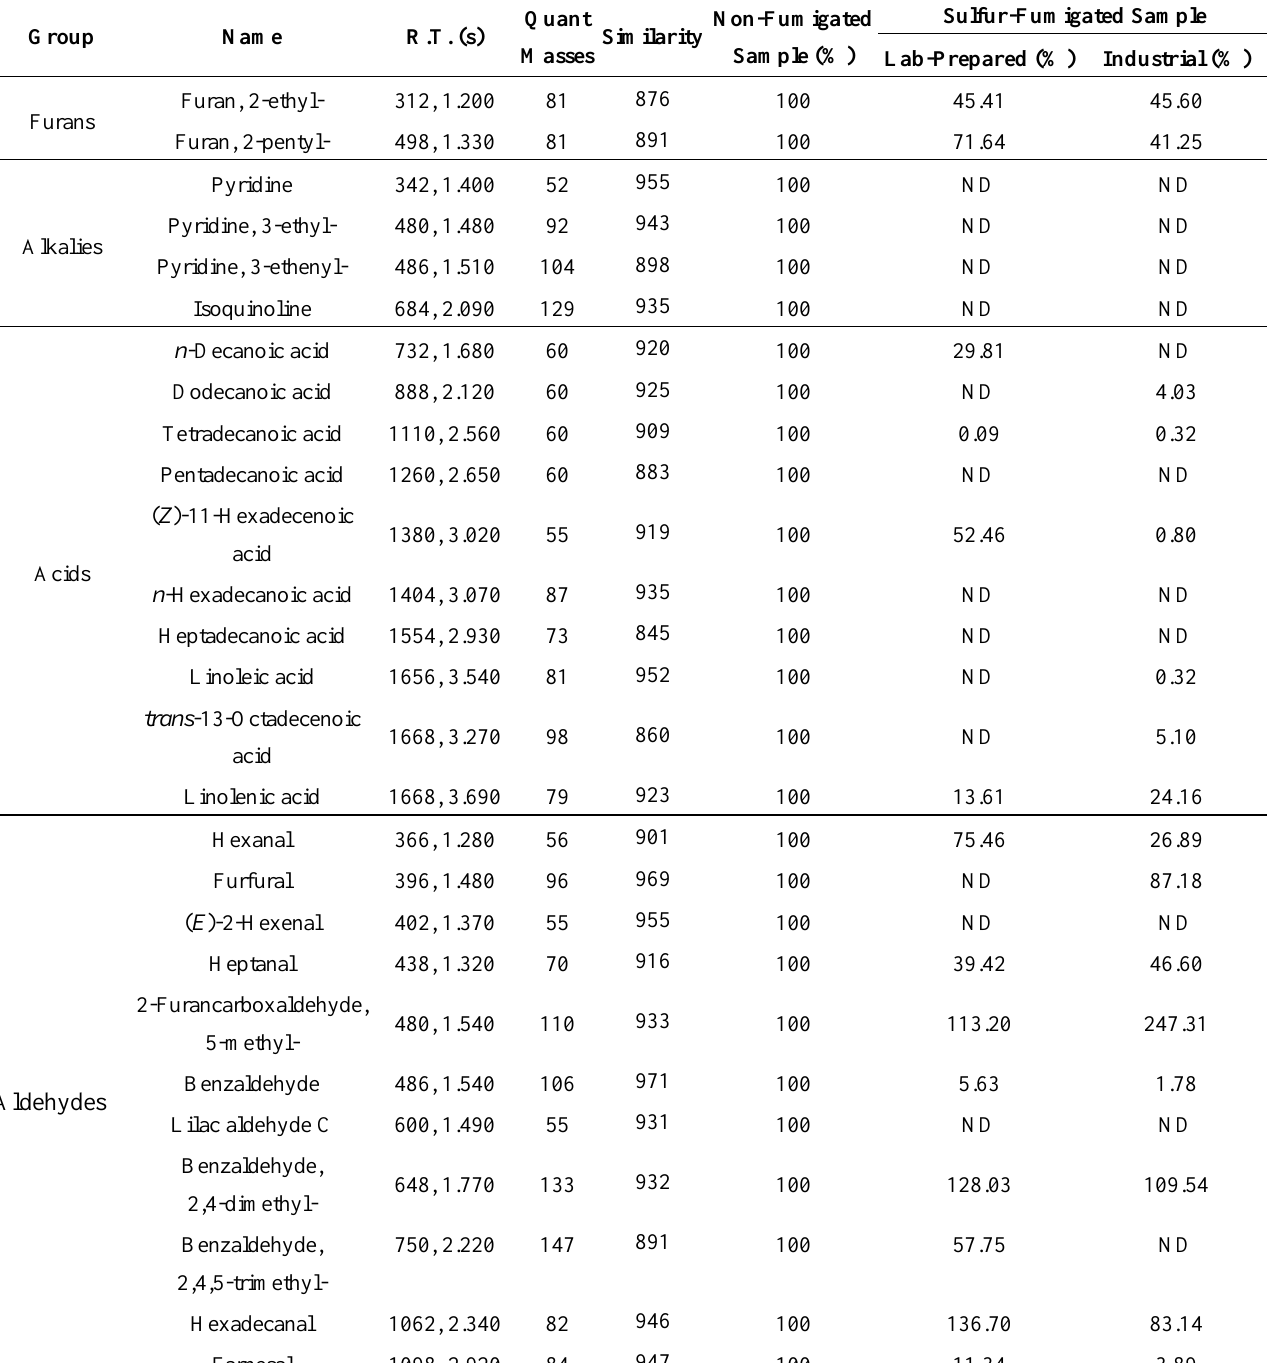
Table 1. 73 representative volatile components identified in non-fumigated